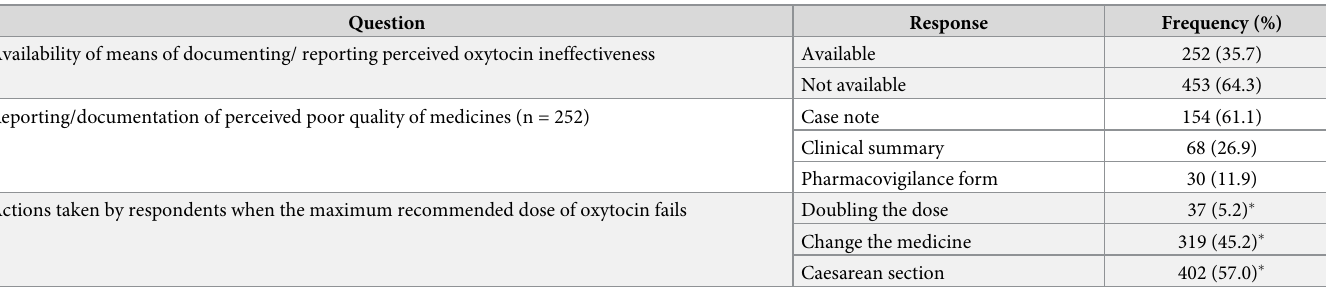
Table 10. Practice following oxytocin use in obstetrics.